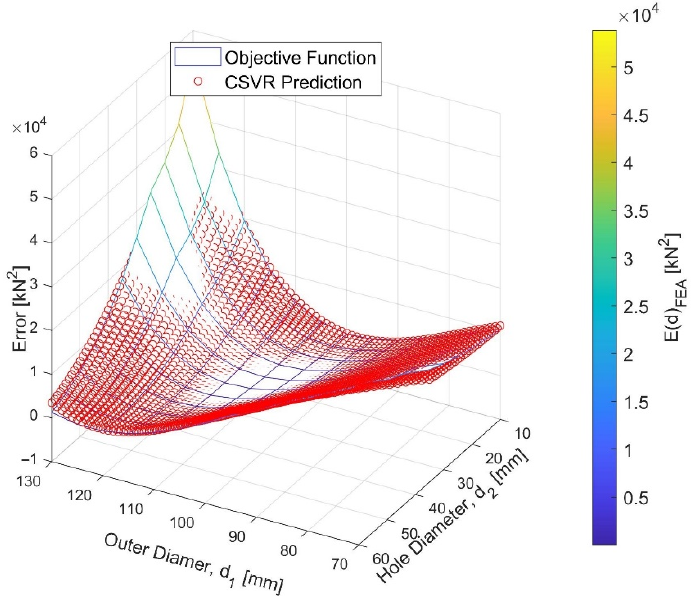
Figure 4. The objective function and the predicted points by the trained SVR metamodel in the design space.